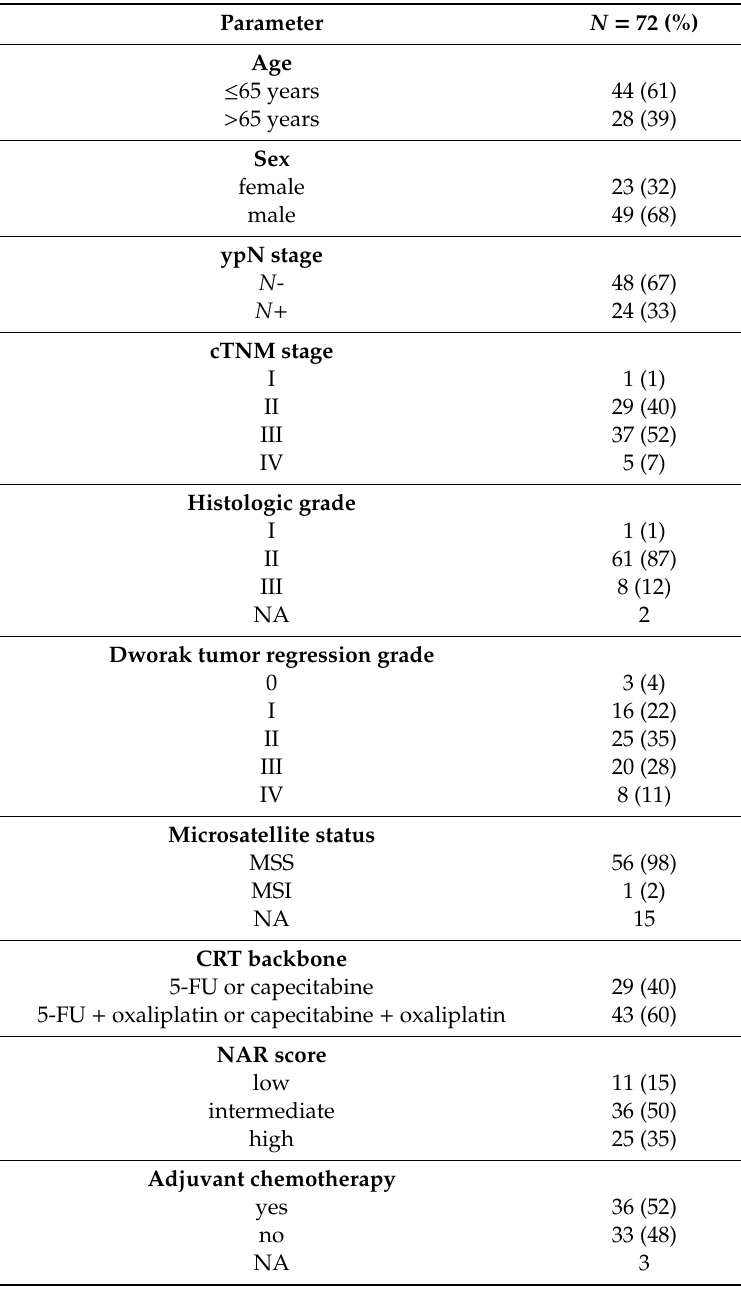
Table 1. Baseline